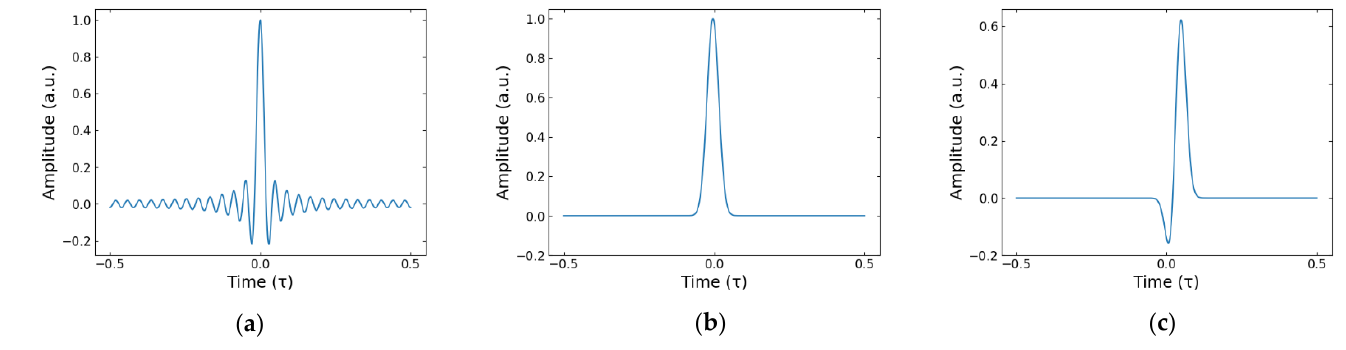
Figure 1. The progression of the sampling kernel through our methodology. ( a ) Time domain response for SoS sampling kernel. Described by h ( t ) from (2) for P = 25. ( b ) The resulting kernel after a Hamming window is applied to the SoS sampling kernel shown to the left. ( c ) Our THz-like sampling kernel. Created by combining two Hamming windowed SoS sampling kernels.